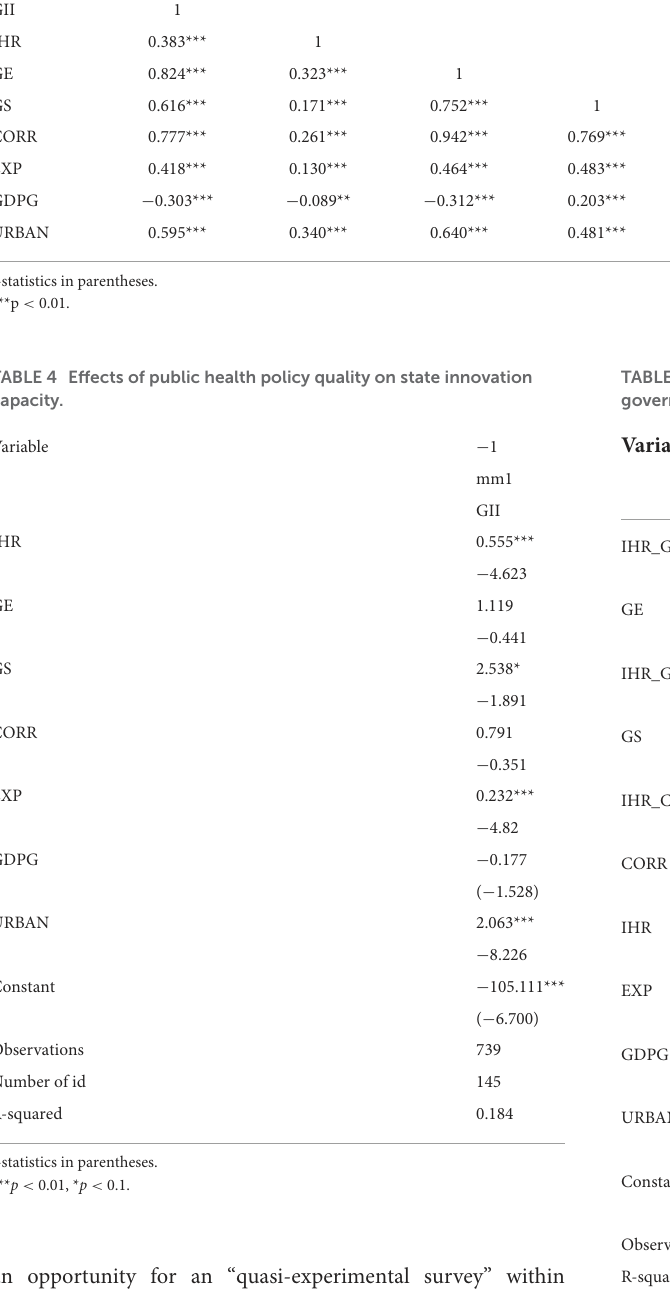
TABLE 3 Correlation matrix of key variables. Variable